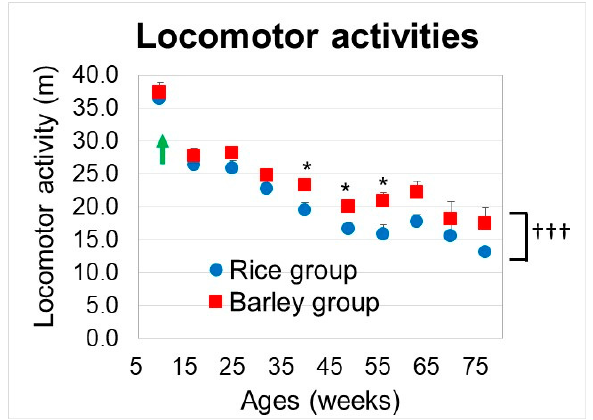
Figure 5. Changes in locomotor activities in SAMP8 mice consuming rice or barley diets during the lifespan. By two-way ANOVA, ††† p < 0.001; group, * p < 0.05; between-group comparison at 39, 48, and 55 weeks old by unpaired t -test. Green arrow; start timing of mild high-fat diets.